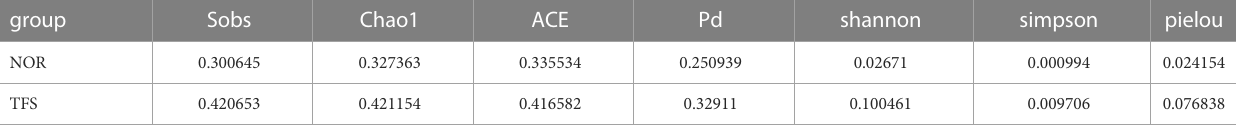
TABLE 1 Coef fi cient of Variation in alpha diversities in the intestinal microbiota of normal (NOR) and TFS D. hystrix .